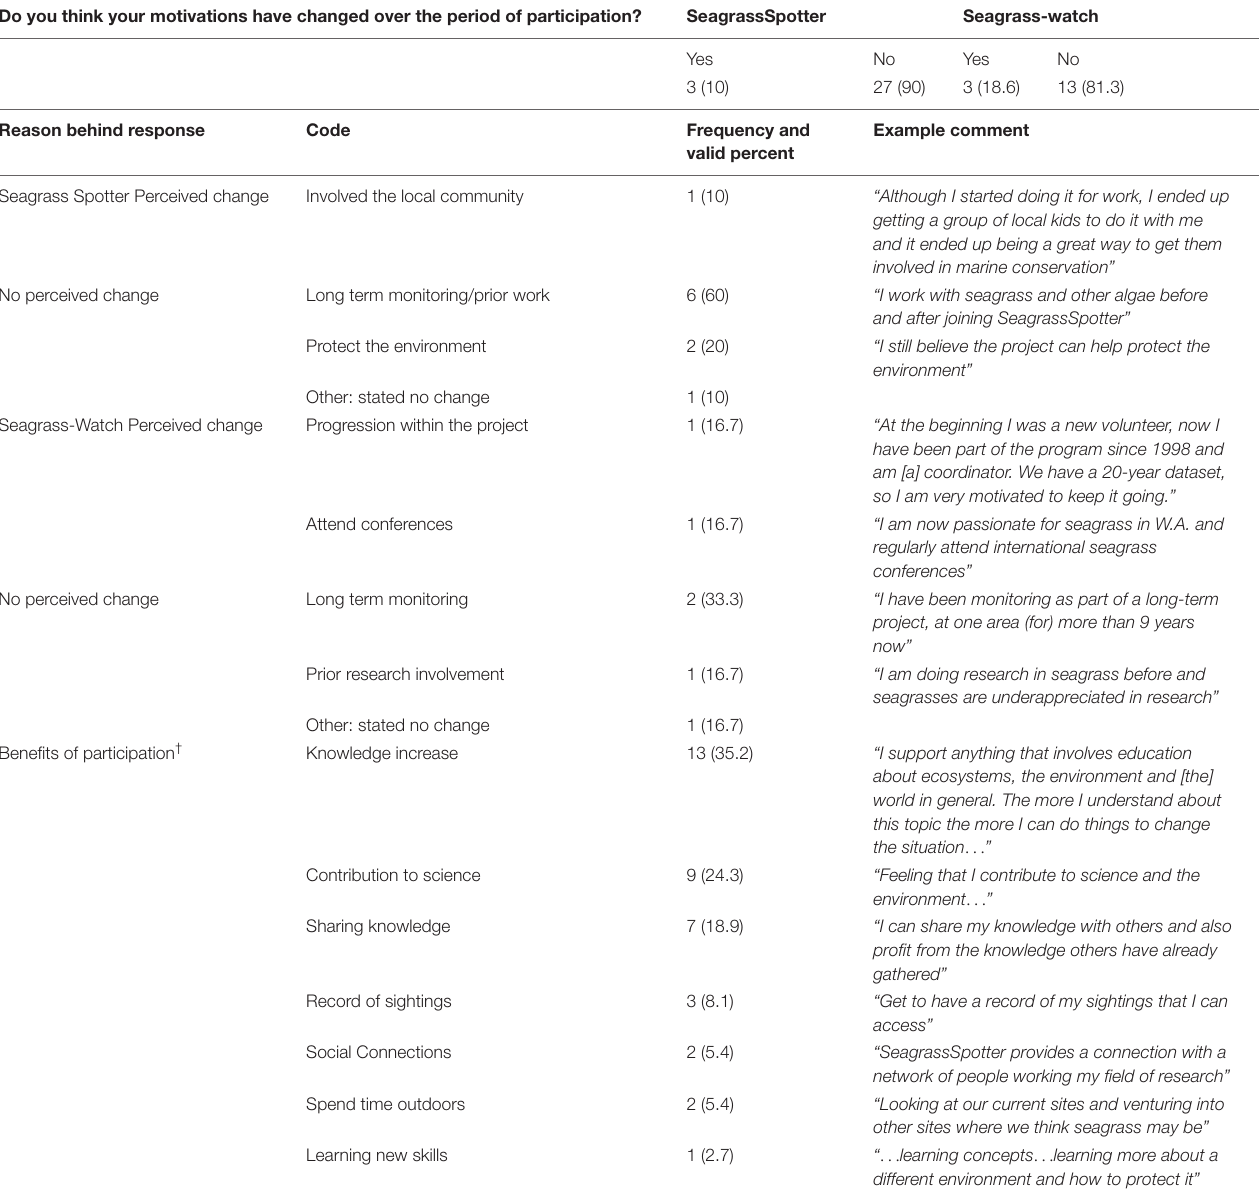
TABLE 6 | Perceived changes in motivations and benefits to participation in seagrass citizen science projects. Do you think your motivations have changed over the period of participation?